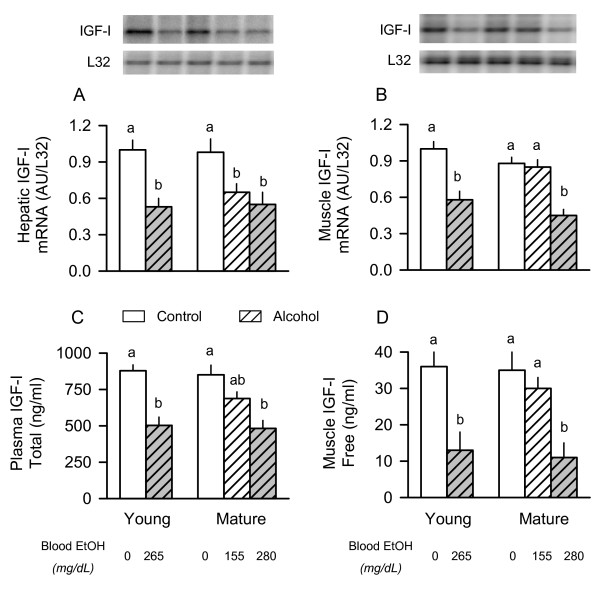
Effect of acute alcohol intoxication on IGF-I concentration and mRNA content in young and mature rats. Inset: representative autoradiographs from a nuclease protection assay (RPA) for IGF-I in liver and gastrocnemius. Graphs A and B: densitometric analysis of RPAs performed on liver and muscle, respectively. Graphs C and D: plasma and muscle IGF-I peptide concentrations were determined by RIA. Groups are the same as described in Figure 1. Values (means ± SEM) where the sample size was 10, 10, 6, 7, 9, and 9 for the six groups, respectively. Values with different letters are significantly different from each other, P < 0.05. Values which share a common letter are not statistically different.